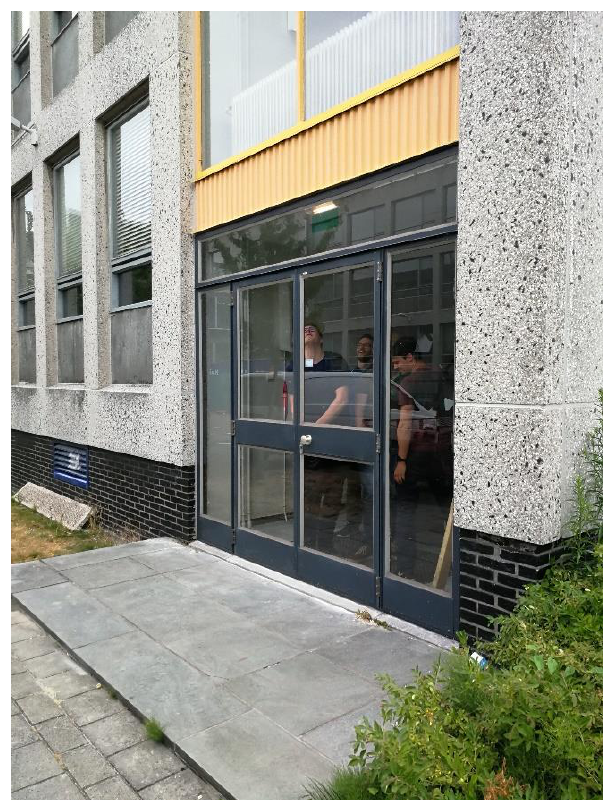
Figure 9. An emergency exits was close during the evacuation